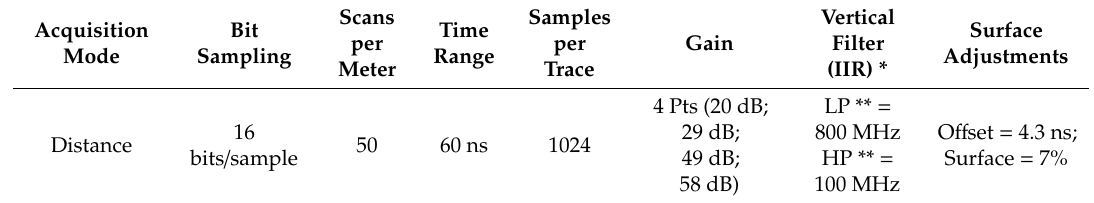
Table 1. Ground-penetrating radar (GPR) configuration used in the Villasviejas del Tamuja